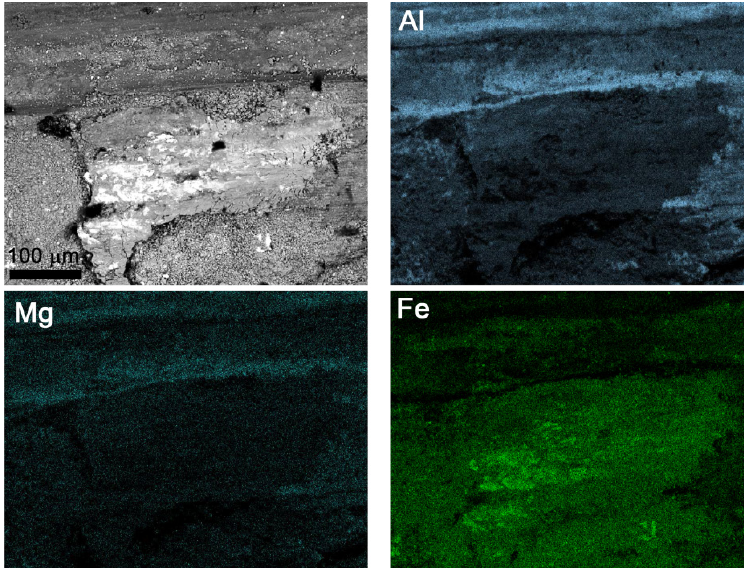
Figure 17. Fe-rich areas on the worn surface of 1.2 g/layer sample.